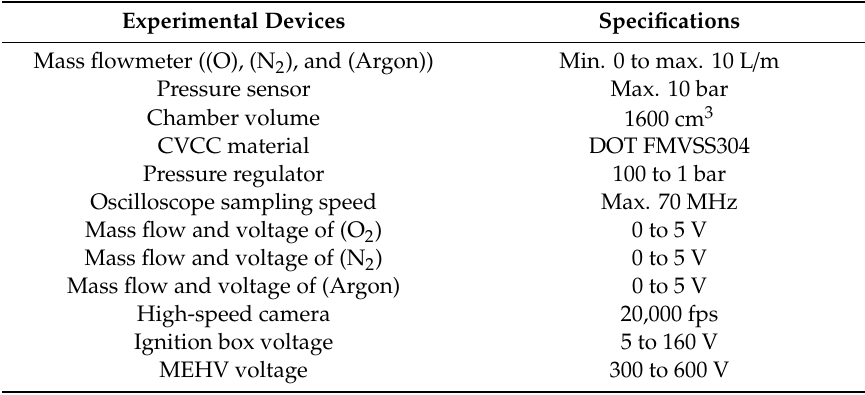
Table 4. Specifications of experimental devices and CVCC system.